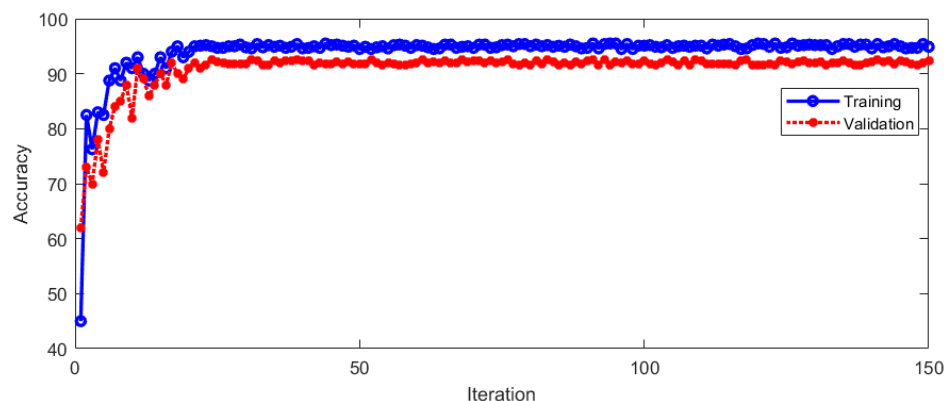
Table 1. Recognition accuracy after model stabilization.